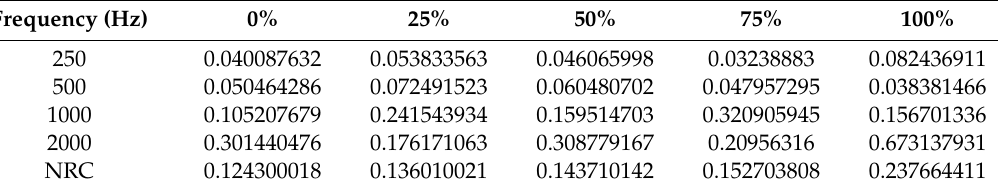
Table 7. Effect of the sawdust content on the noise reduction coefficient (NRC).